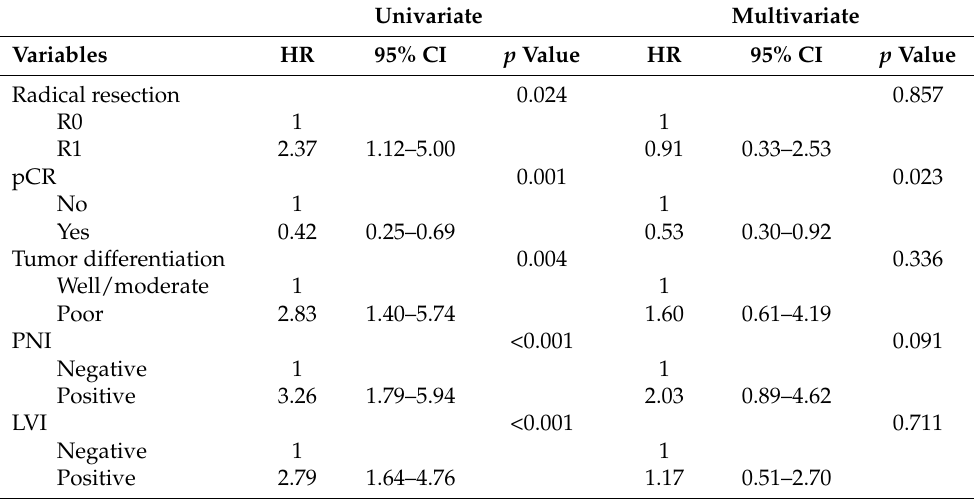
Table 4. Univariate and multivariate Cox regression model for locoregional-specific DFS. Univariate